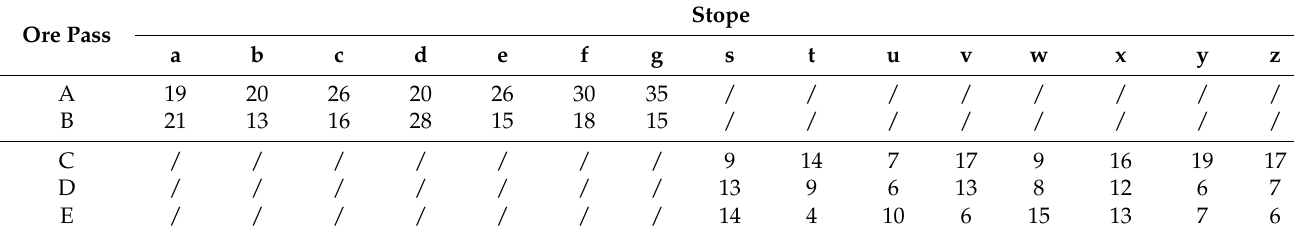
Figure 6. Change curve of the target optimization value with evolutionary generation. Table 8. Loaded haulage number of times of the scraper (Units: 1).